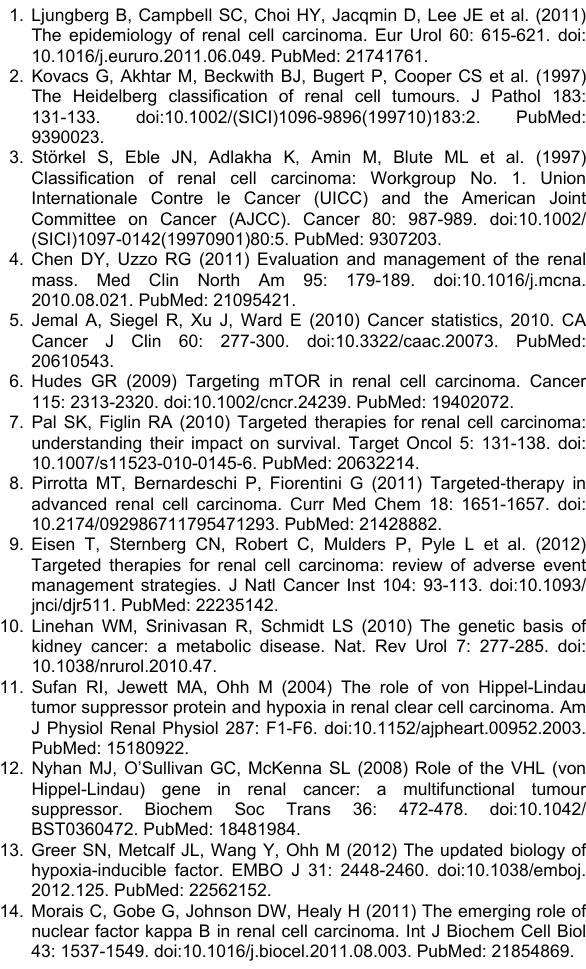
Table S3. The ccRCC NF-κB gene signature sorted by category.